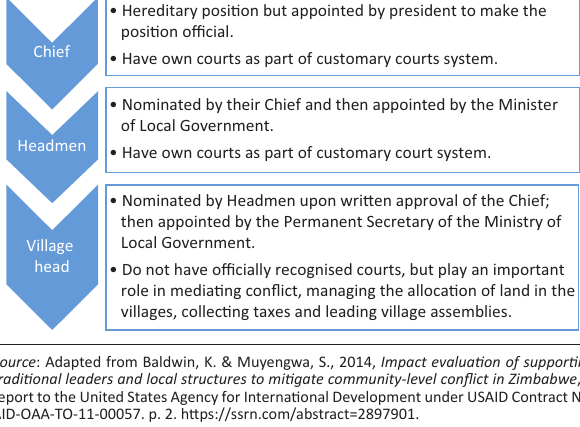
FIGURE 1: Hierarchy of traditional leadership in